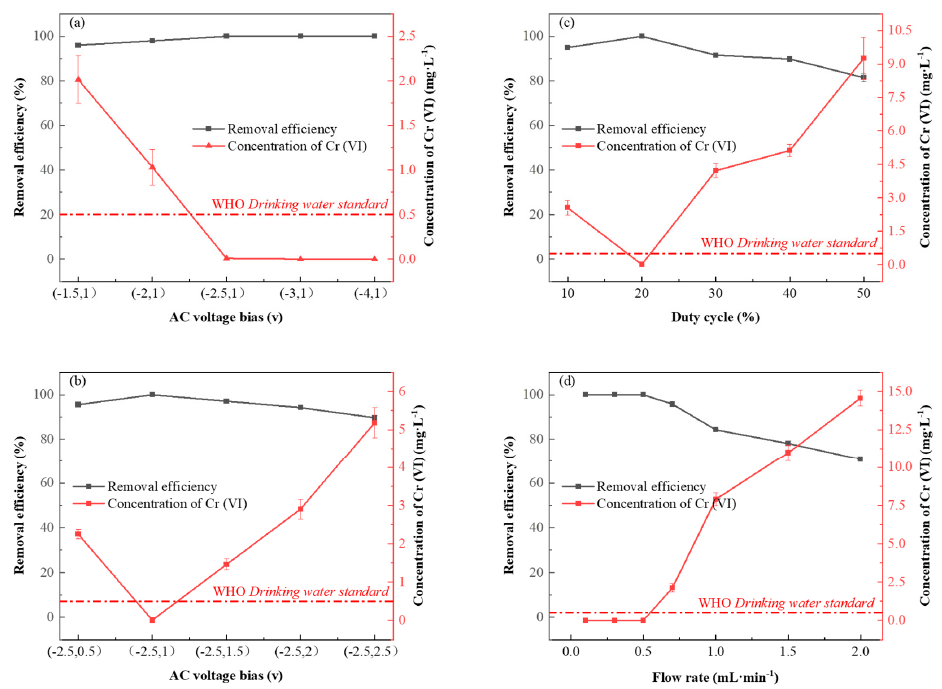
Figure 4. ( a ) Comparison of removal rate under different negative bias. ( b ) Comparison of removal rate under different positive bias. ( c ) Comparison of removal rate under different duty cycle. ( d ) Comparison of removal rate at different flow rates.